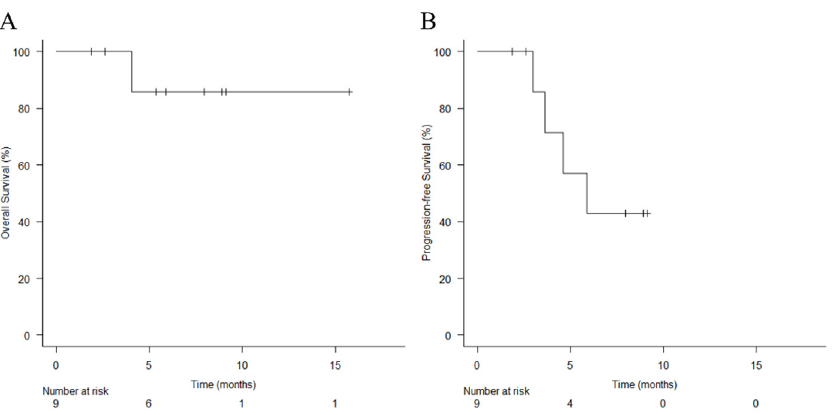
Figure 2. Kaplan–Meier curves of ( A ) overall survival and ( B ) progression-free survival. Vertical lines show censored events.